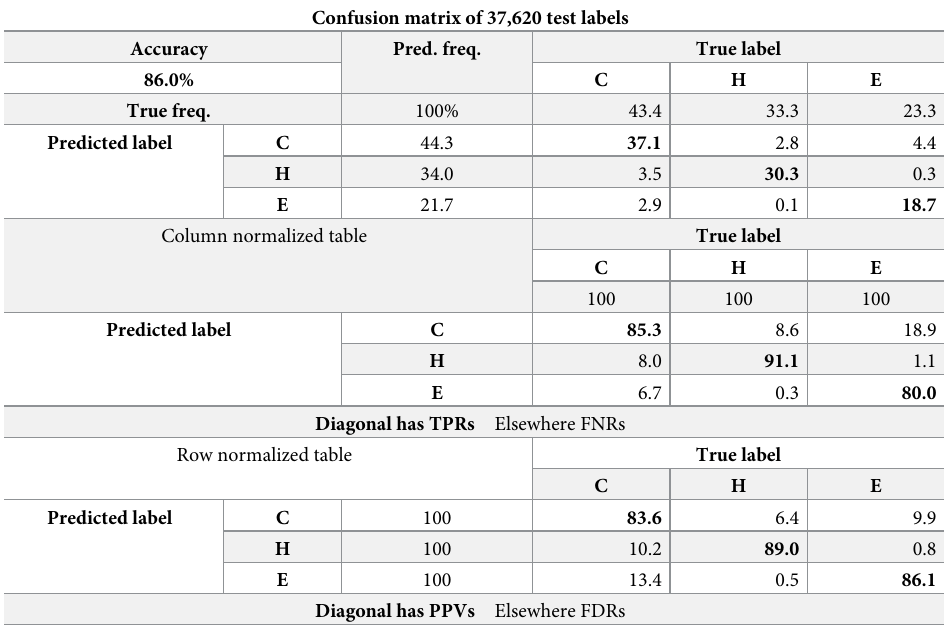
Table 12. Final 3-label alphabet: H , C , and E : (1) confusion matrix, (2) TPR and TNR and (3) PPV and FDR of SecNet